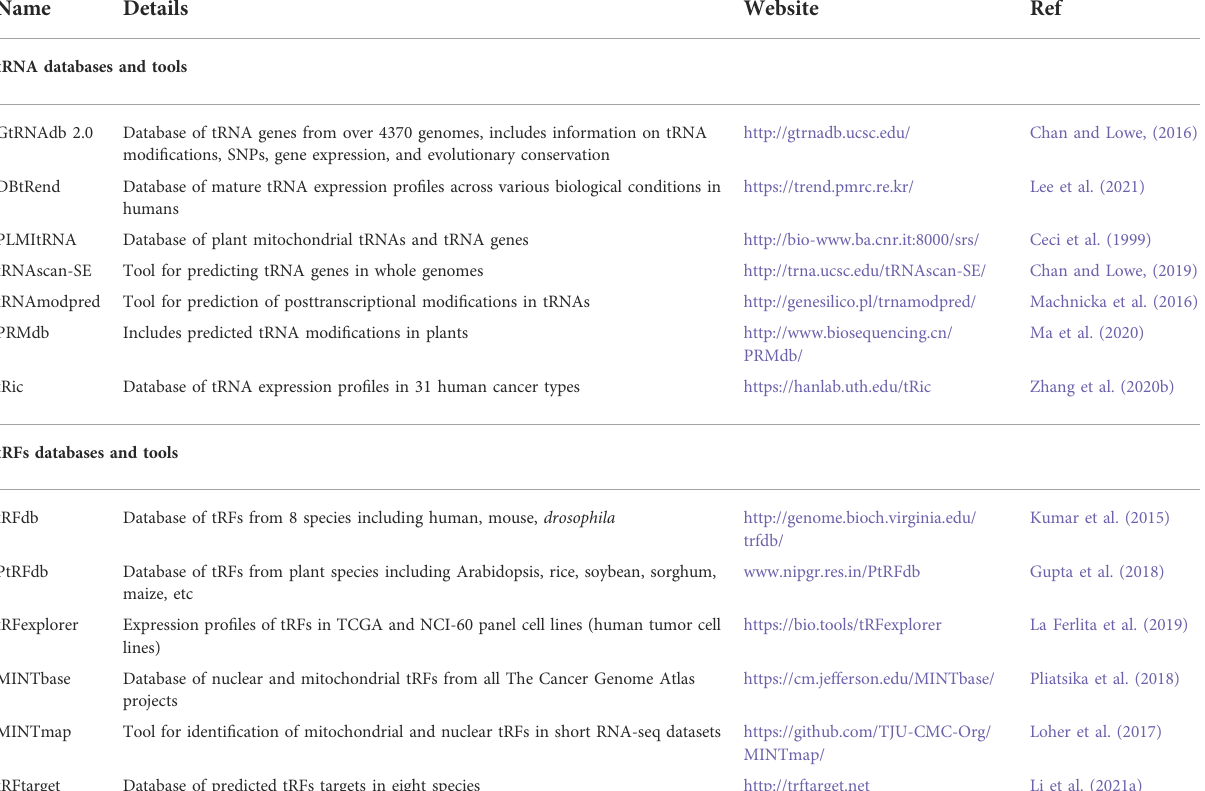
TABLE 3 Databases and tools for tRNAs and